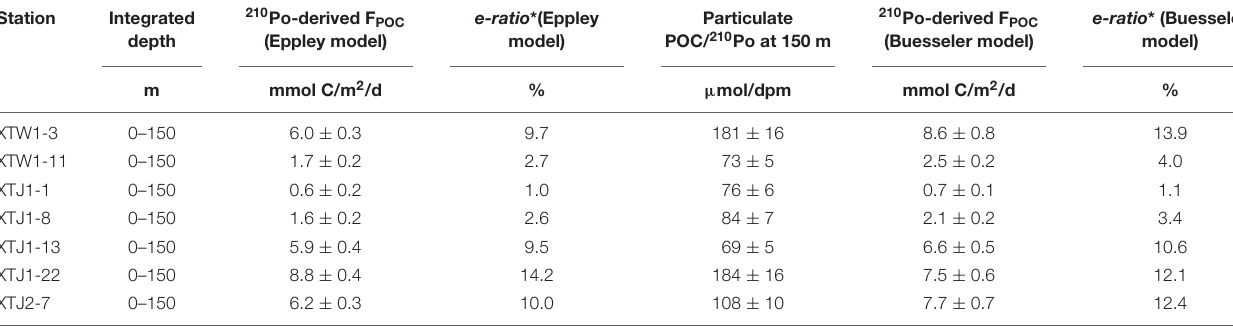
TABLE 3 | POC fluxes and e-ratios derived from 210 Po tracer by the Eppley and Buesseler models.